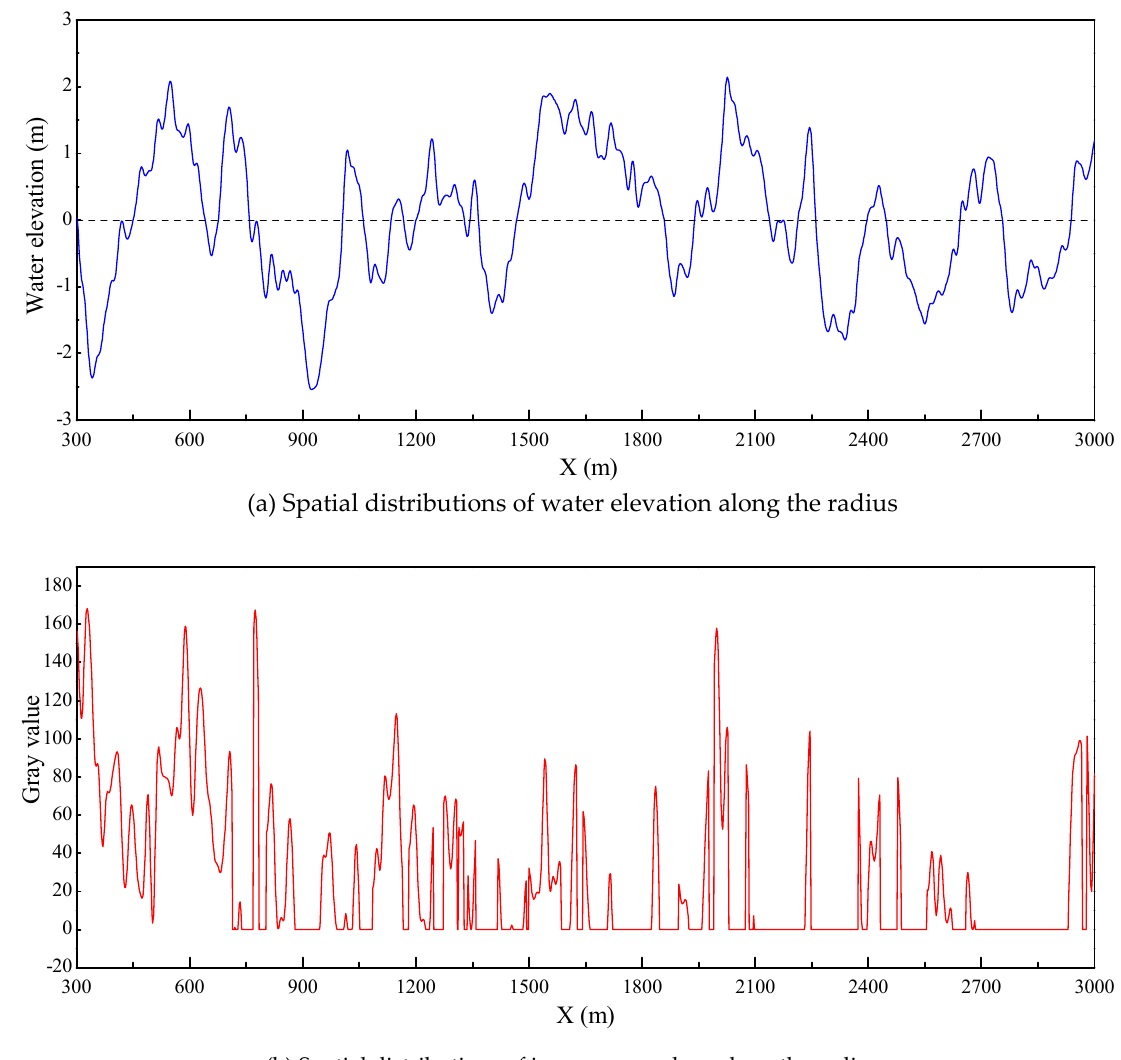
Figure 3. A numerical simulated radar image (the left part) and the cropped portion (right).